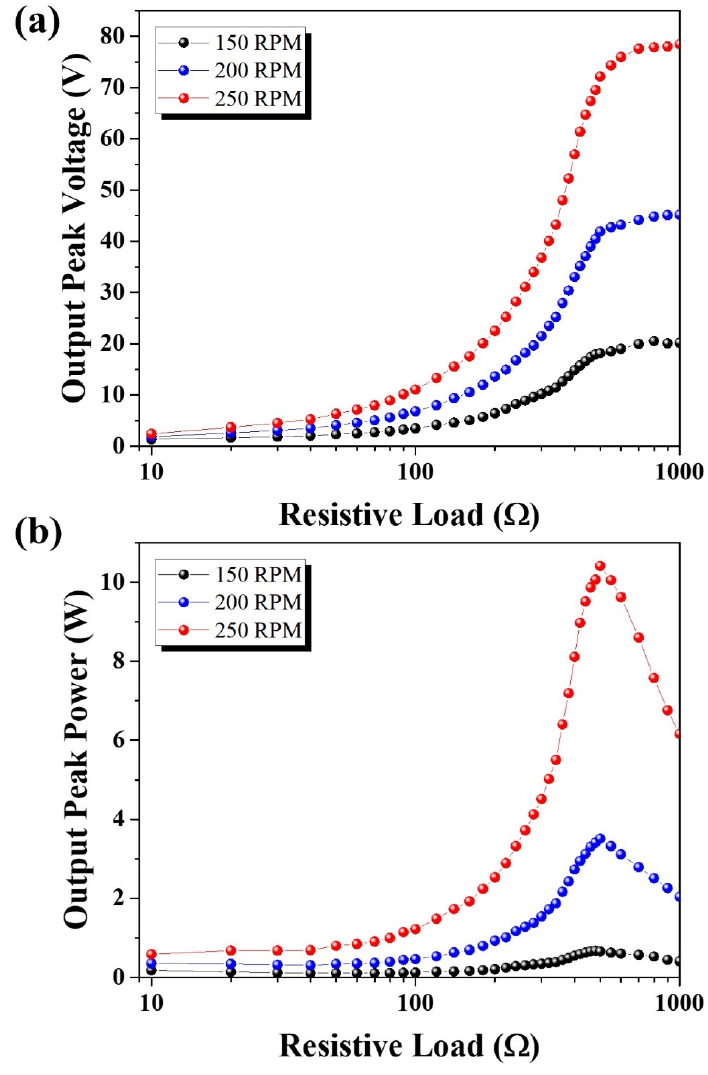
Figure 8. ( a ) Output voltage and ( b ) output power characteristics provided by primary impact for hammer-impact-driven power generator with variation of impeller rotation speed and resistive